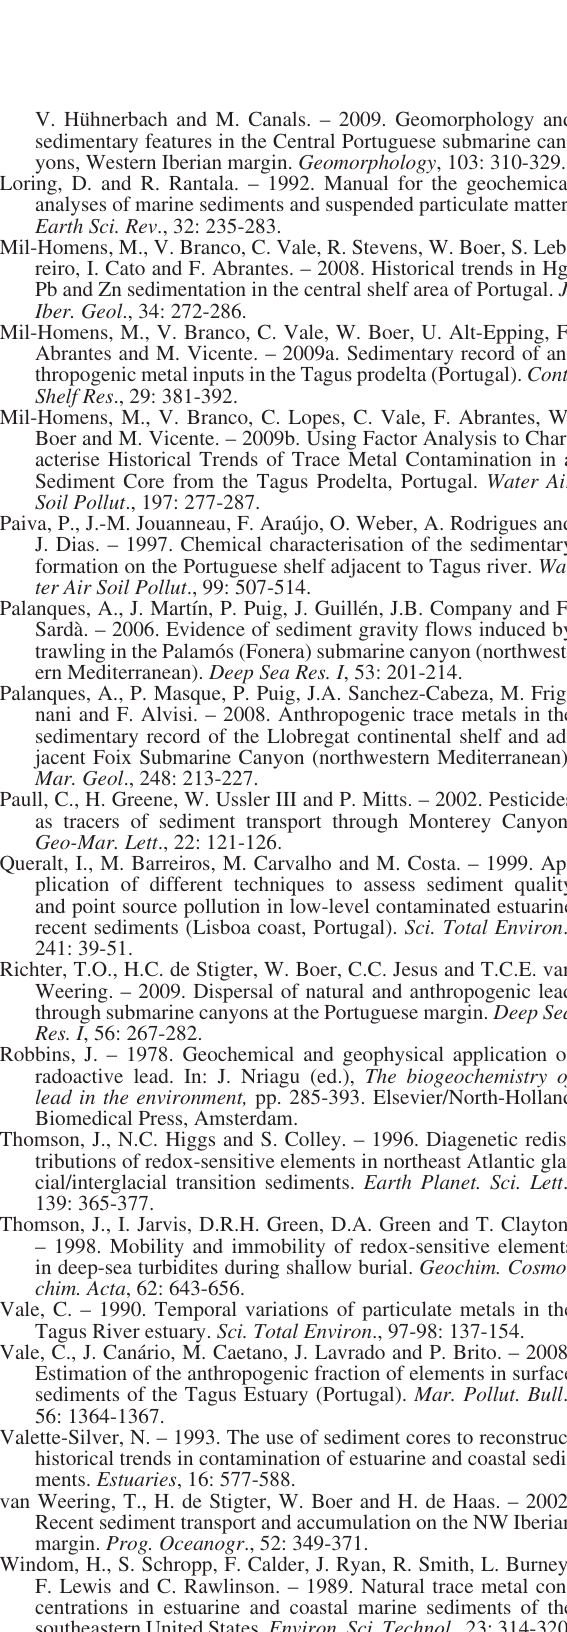
Figuères, G., J. Martin, M. Meybeck and P. Seyler. – 1985. A com- parative study of mercury contamination in the Tagus estuary (Portugal) and major French estuaries (Gironde, Loire, Rhone). Estuar. Coast. Shelf Sci ., 20: